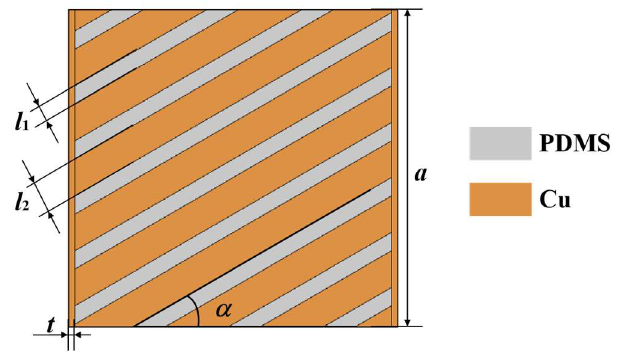
Figure 4. Schematic of one square unit as a module in the meta-structure.